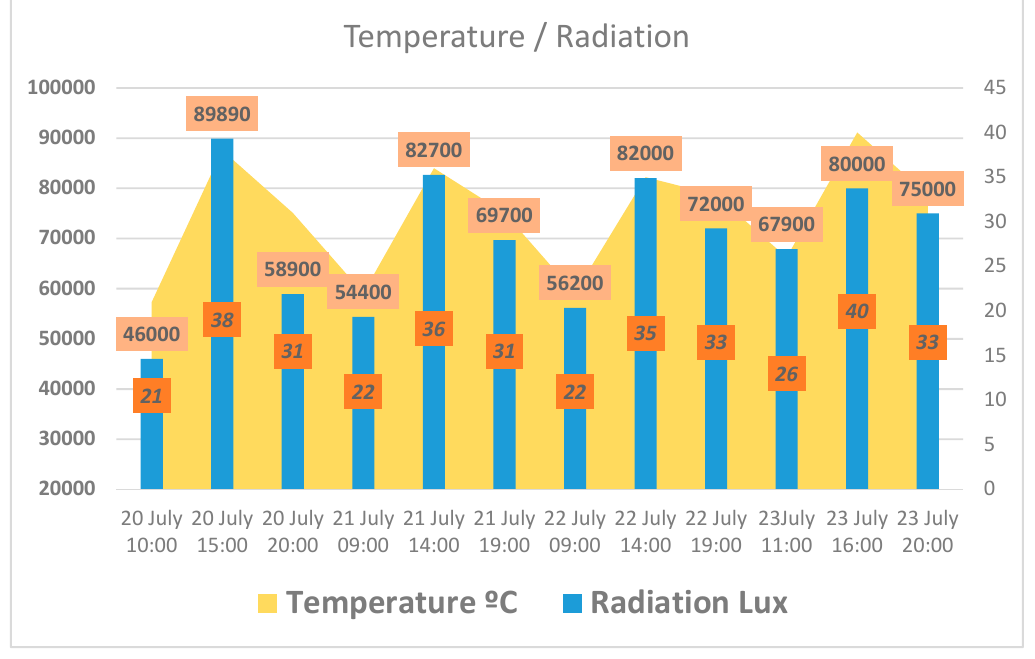
Figure 21. Relationship between temperature and solar radiation at different times of day.